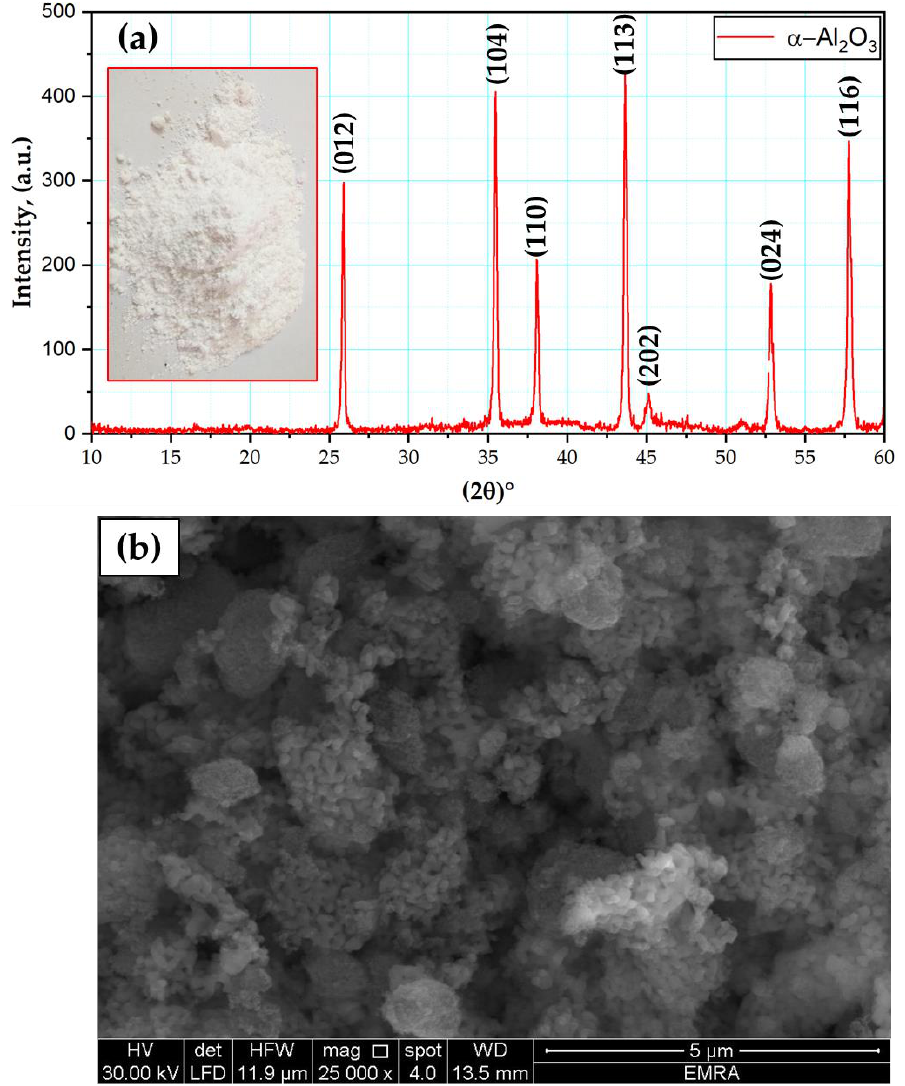
parameters for comparison purposes to investigate the role of the nano Al 2 O 3 reinforcement on the behavior and properties of the FSDed composites.